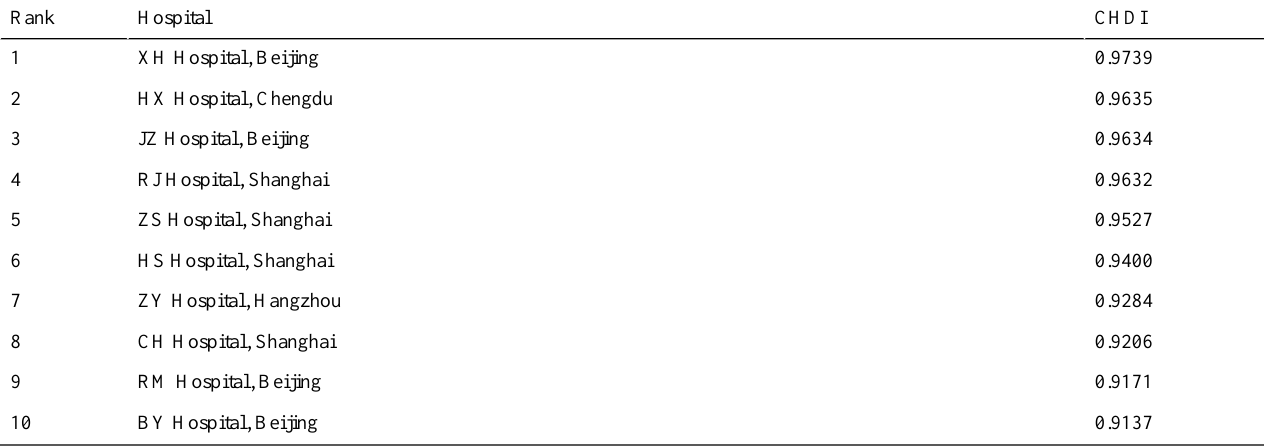
Table 6. An example of the China Hospital Development Index (CHDI) ranking results.